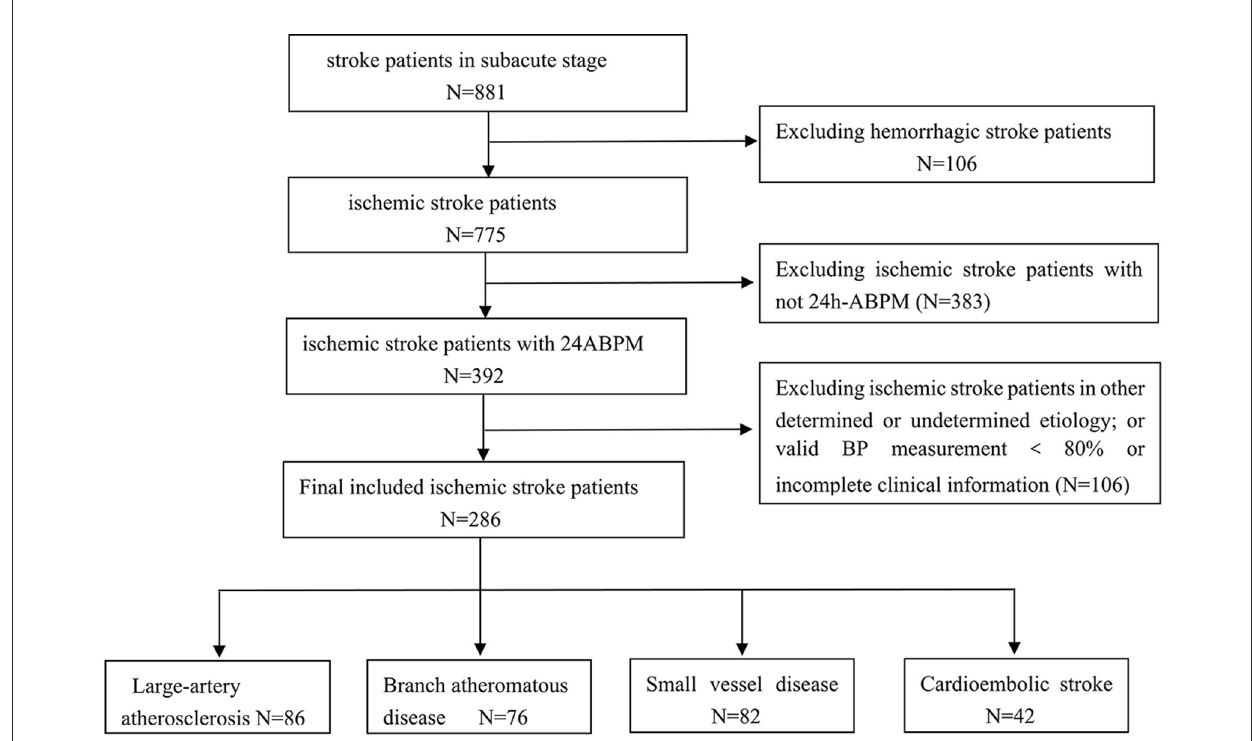
FIGURE1 Flowchart of patients included in the study. ABPM, ambulatory blood pressure